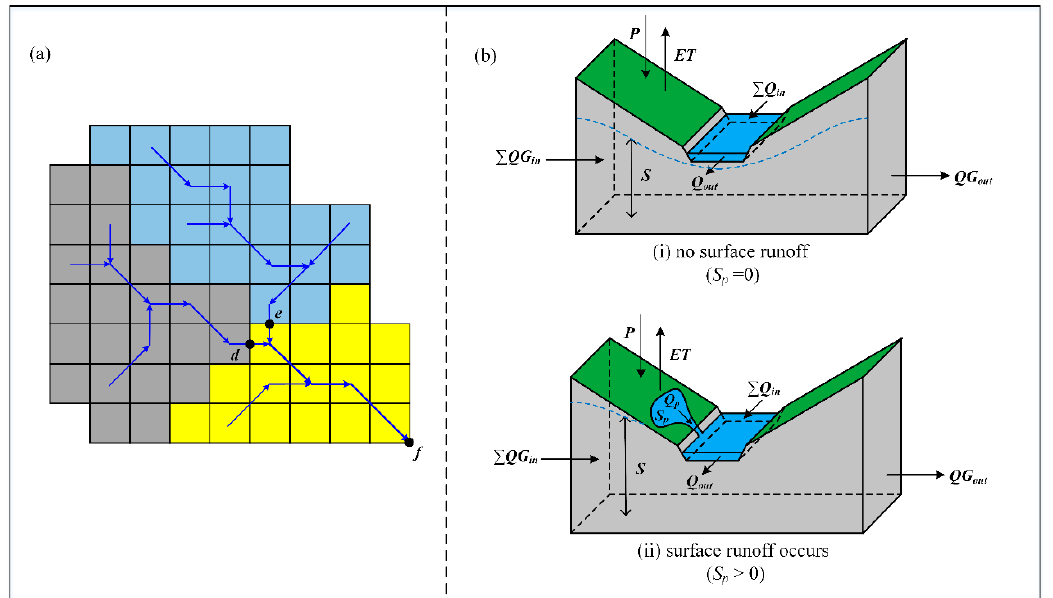
Figure 5. Graphical summary of the DEM-based Distributed Rainfall-Runoff Model (DDRM) structure. ( a ) Discretization of the catchment into several sub-catchments and grids, and delineation of streamflow routing (blue lines) in DDRM. d , e, and f represent, respectively, the outlet of the grey-shaded sub-catchment, the light blue-shaded sub-catchment, and the whole catchment. ( b ) Hydrological processes in excess rainfall generation calculation in each grid and streamflow movement across grids in DDRM.